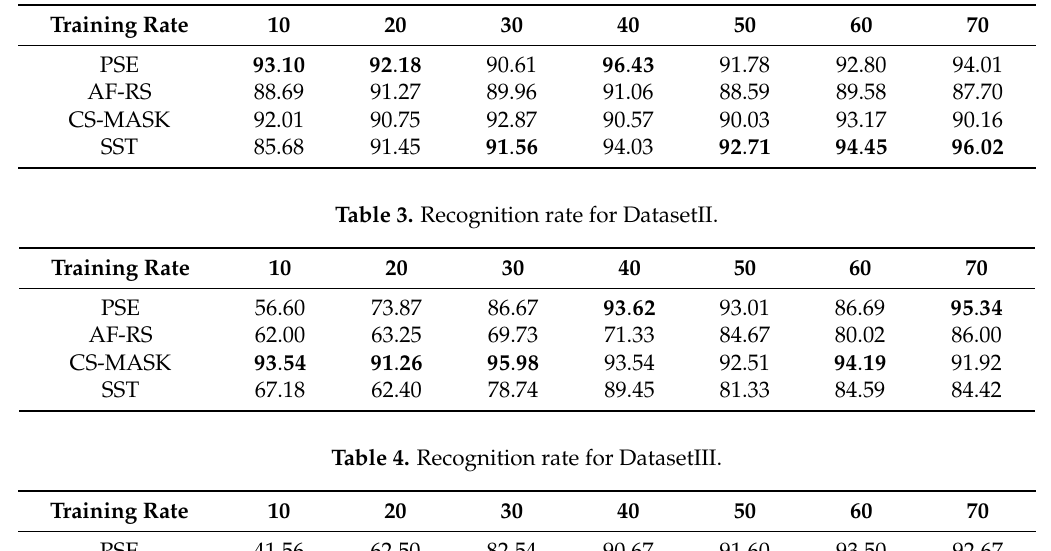
Table 2. Recognition rate for DatasetI.